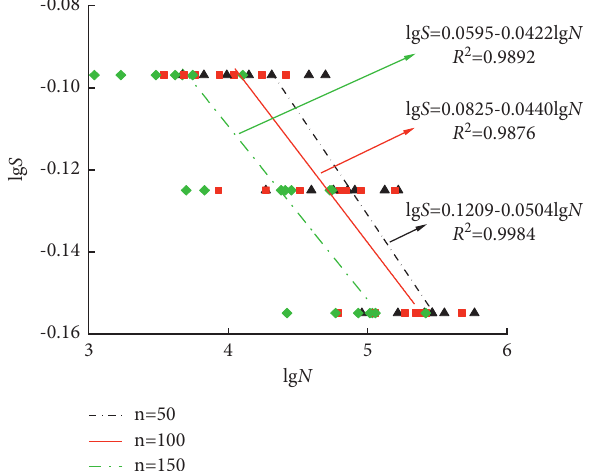
Figure 7: lg S- lg N curves of the average fatigue life frost-damaged AASC.